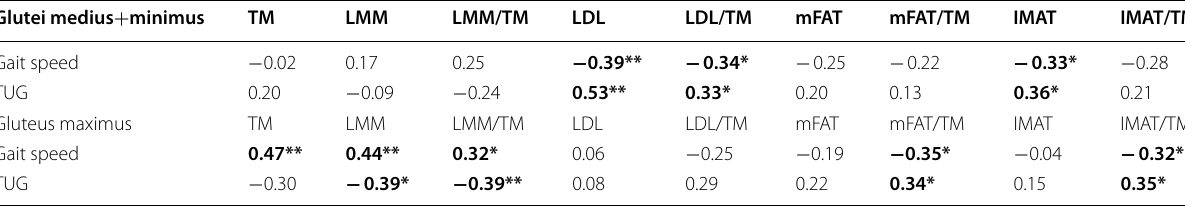
Table 3 Pearson’s correlation coefficients between muscle composition and postoperative gait